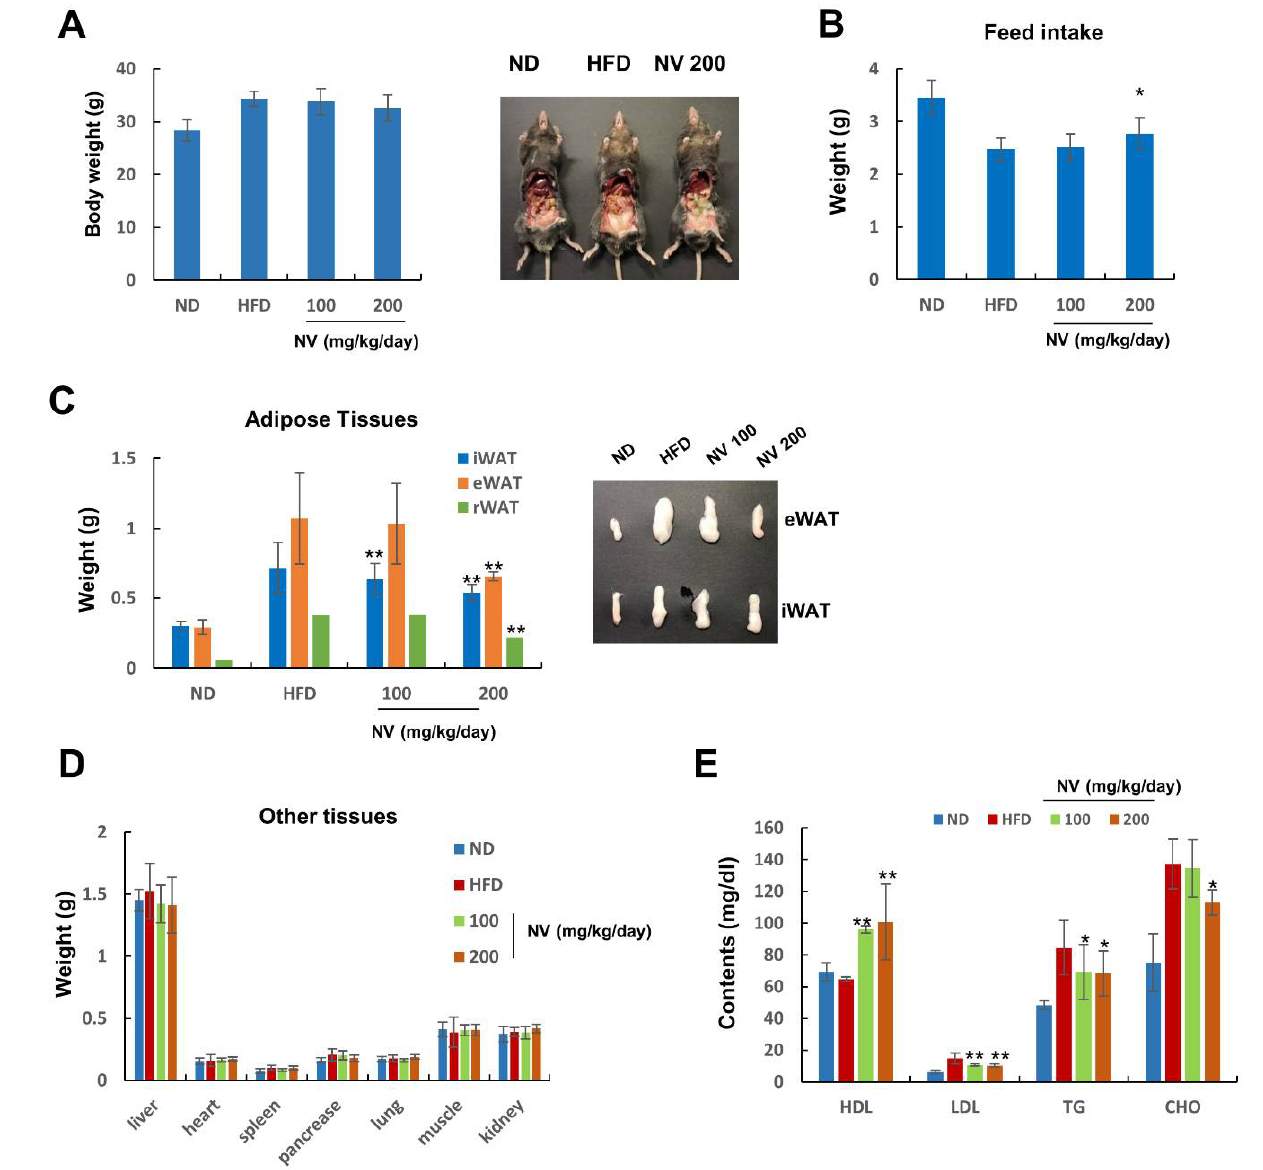
Figure 2. Effects of NV on adipose tissue expansion and plasma lipid content in HFD-induced obese mice. The ND group (n = 7) was fed a normal diet, the HFD group (n = 7) was fed an HFD, and the NV 100 and NV 200 groups (n = 7) were fed an HFD plus NV at the indicated concentrations (100 and 200 μg/mL, respectively). ( A ) Body weight was measured at the end of the animal study (left). Representative images of the abdominal organs from the indicated mice groups are shown (right). ( B ) Food intake was recorded every 3 days throughout the study. ( C ) Adipose tissue weight (left) and representative eWAT and iWAT images (right) are shown. ( D ) Liver, heart, spleen, pancreas, lung, muscle, and kidney weights are shown. ( E ) Plasma HDL, LDL, TG, and CHO levels were measured. Significant differences from the HFD group are indicated by ** p < 0.01 and * p < 0.05. Bar graphs show the mean ± standard deviation from five individual mice per group. NV, Nidus vespae extract; HFD, high-fat diet; eWAT, epididymal white adipose tissue; iWAT, inguinal white adipose tissue; rWAT, retroperitoneal white adipose tissue; HDL, high-density lipoprotein; LDL, low-density lipoprotein; TG, triglyceride; CHO,